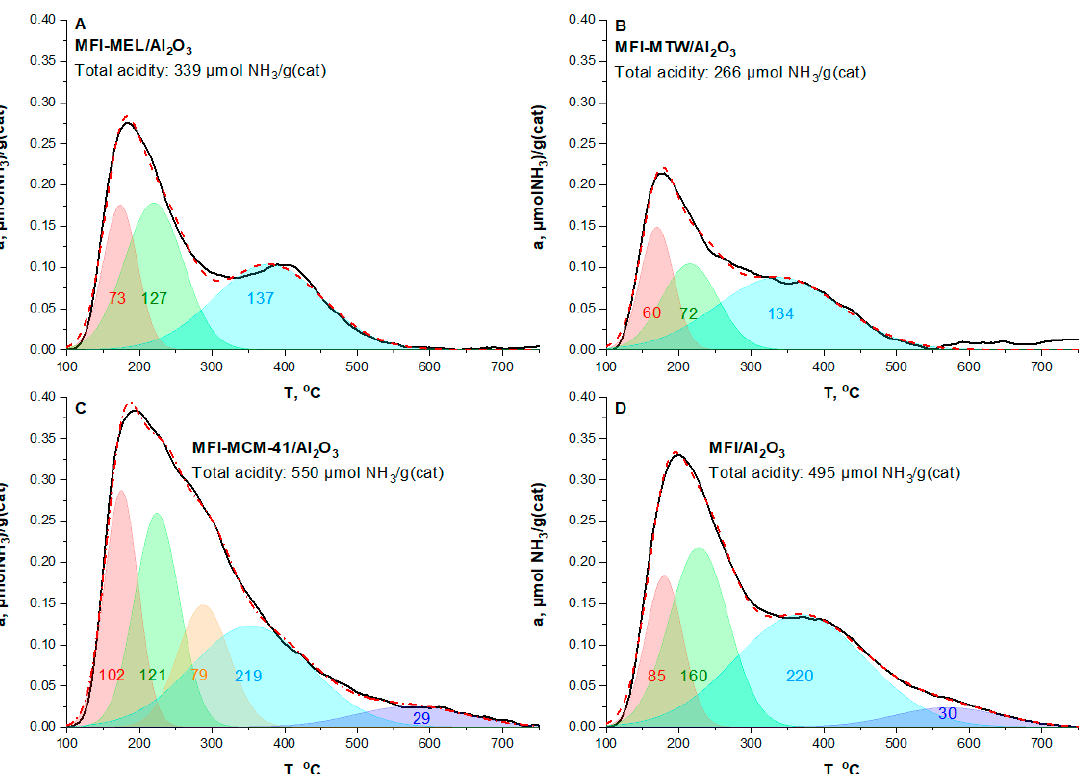
Figure 2. NH 3 ‐ TPD profiles of ammonia: ( A ) MFI ‐ MEL/Al 2 O 3 , ( B ) MFI ‐ MTW/Al 2 O 3 , ( C ) MFI ‐ MCM ‐ 41/Al 2 O 3 , ( D ) MFI/Al 2 O 3 and their deconvolution into Gaussian peaks. The black solid line is the experimental curve. The red dotted line is the cumulative curve of Gaussian peaks. Numbers indicate the amount of acid sites corresponding to the peak, μ mol NH 3 /g(cat).